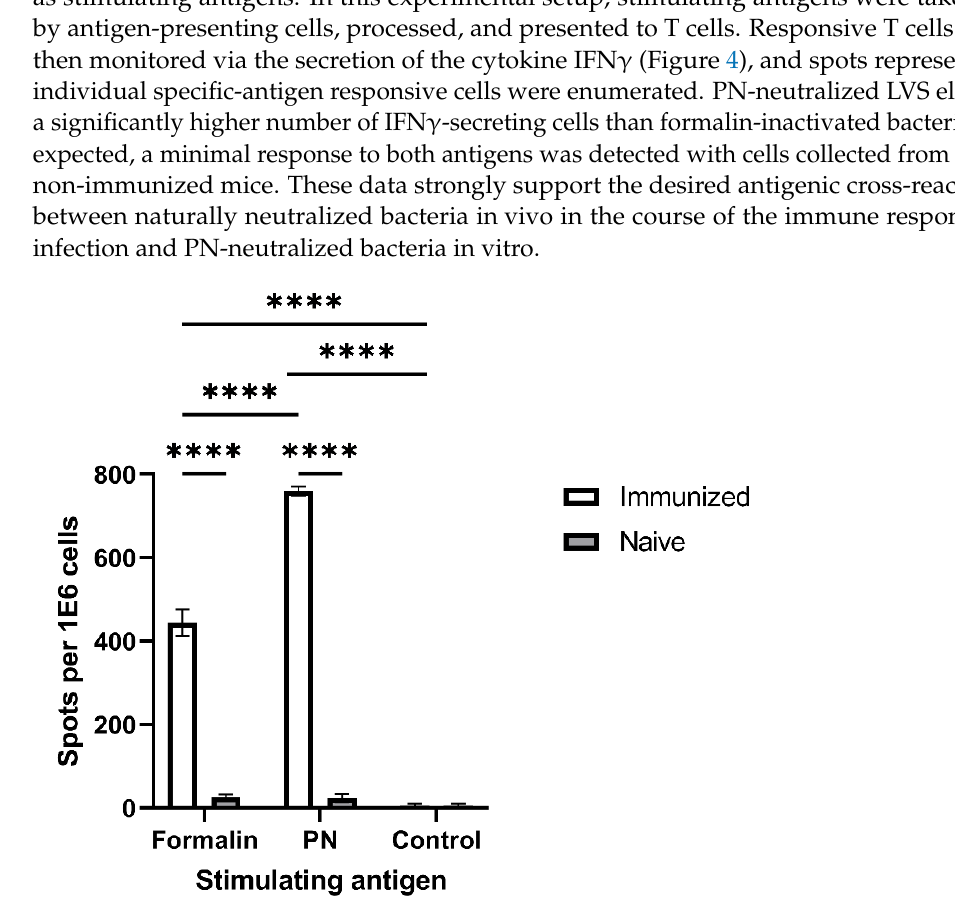
Figure 4. T cell response to whole bacterial antigens inactivated by formalin or peroxynitrite. Splenocytes from immunized mice were incubated with formalin- or peroxynitrite (PN)-neutralized F. tularensis LVS bacteria for 24 h. T cell response was measured by an IFN γ ELISPOT test. (****) p < 0.0001.